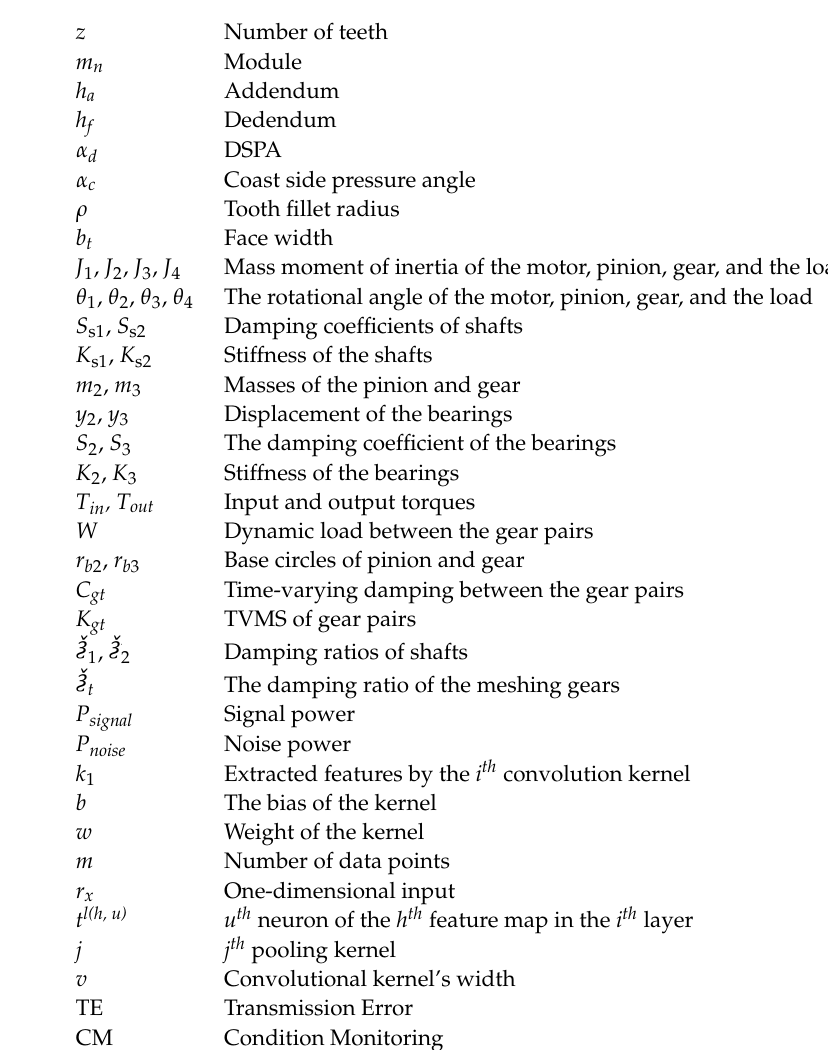
Table 2. Constant coe ffi cients of the dynamic model [43–45].